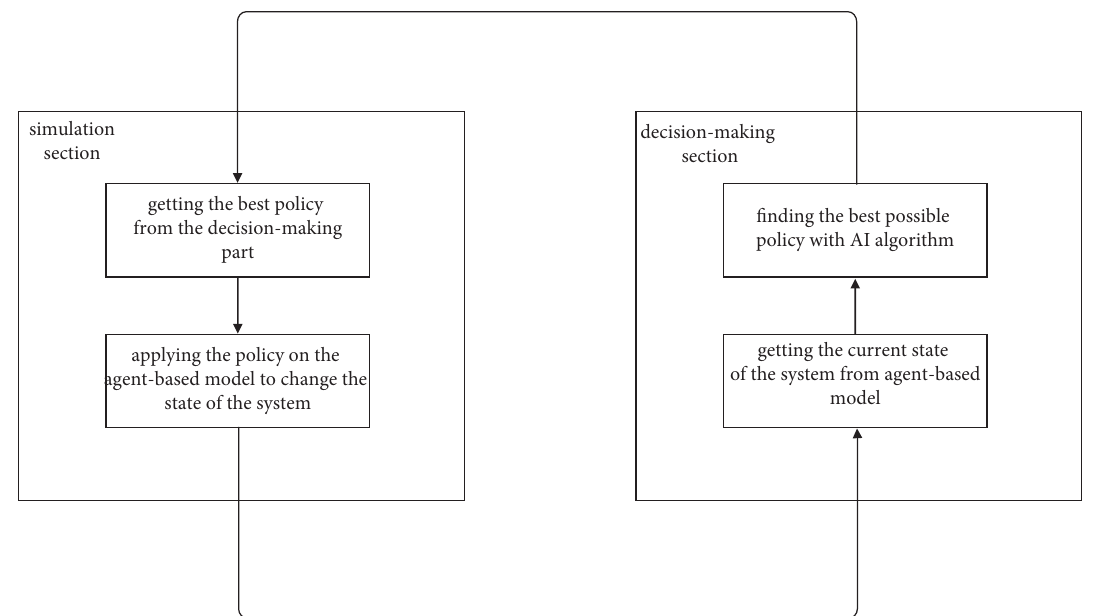
Figure 2: The relationship between simulation and DM parts in intelligent system